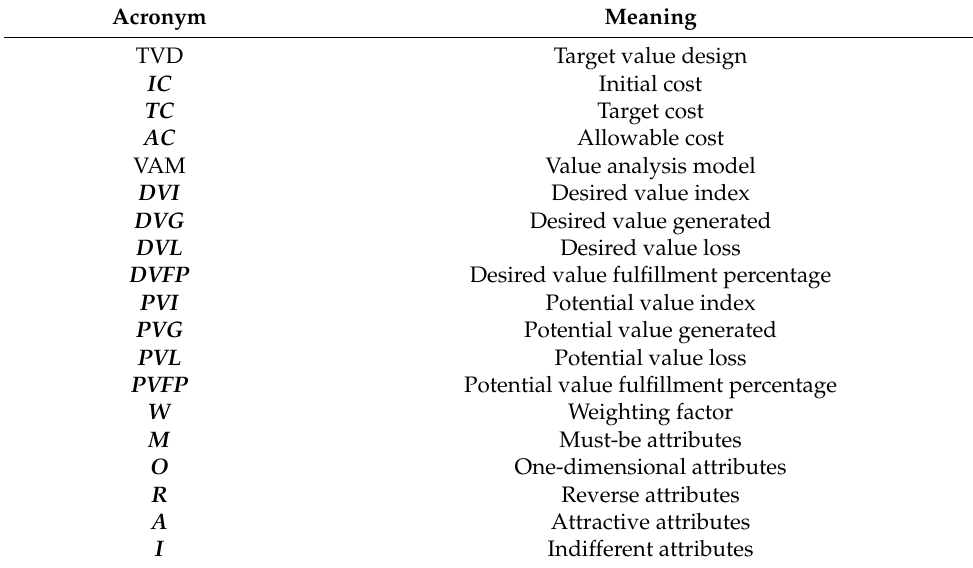
Table 3. Acronyms